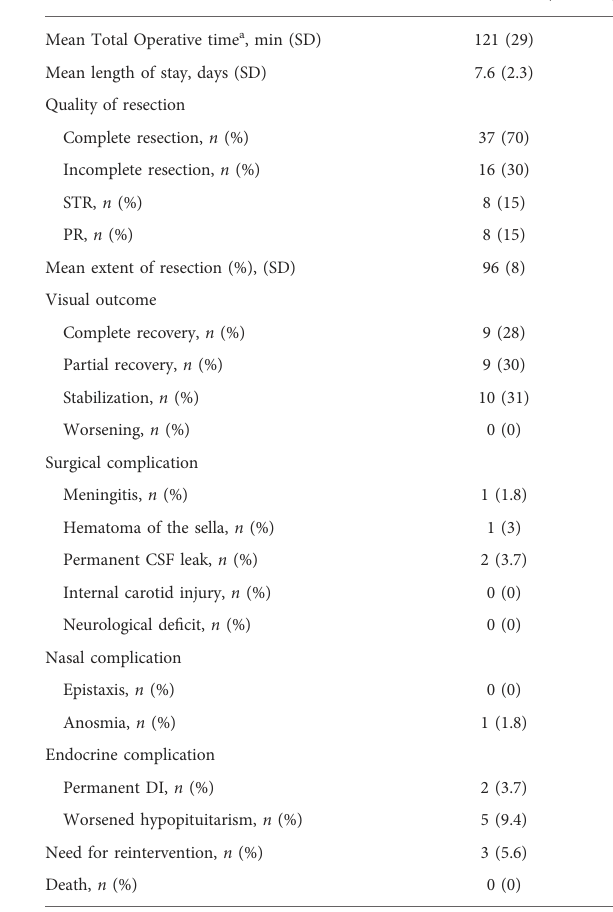
TABLE 2 Intra-operative course and post-operative